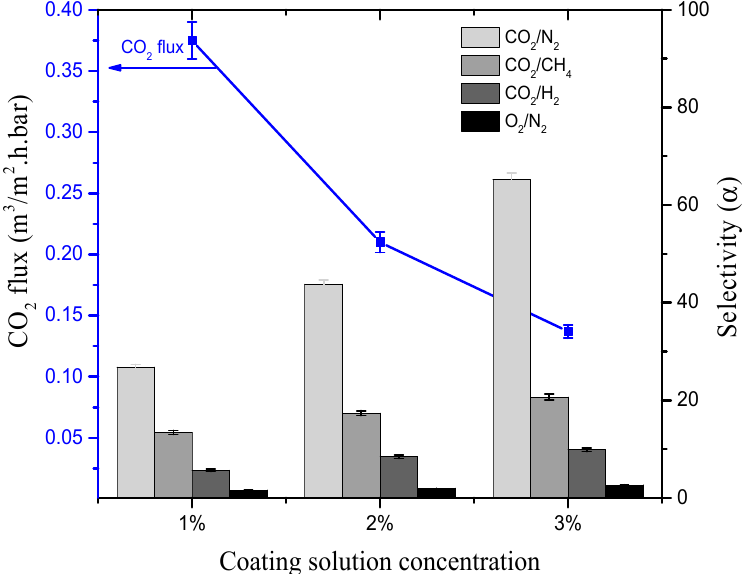
Figure 10. Effect of CO 2 flux and gas selectivities at various concentration of PAN- r -PEGMA67 copolymer coating solution.